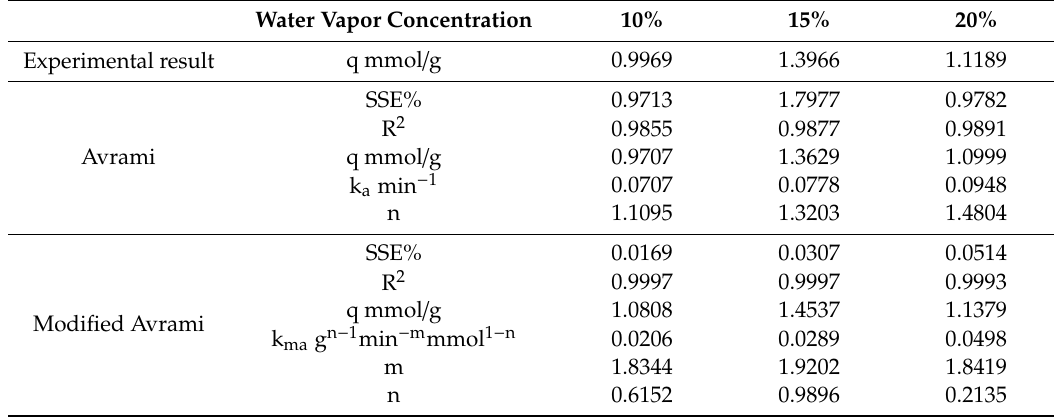
Figure 8. Adsorption characteristics and model fitting results with different water vapor concentrations. Table 6. Fitting parameters of experimental data for adsorption characteristics under different water vapor concentrations